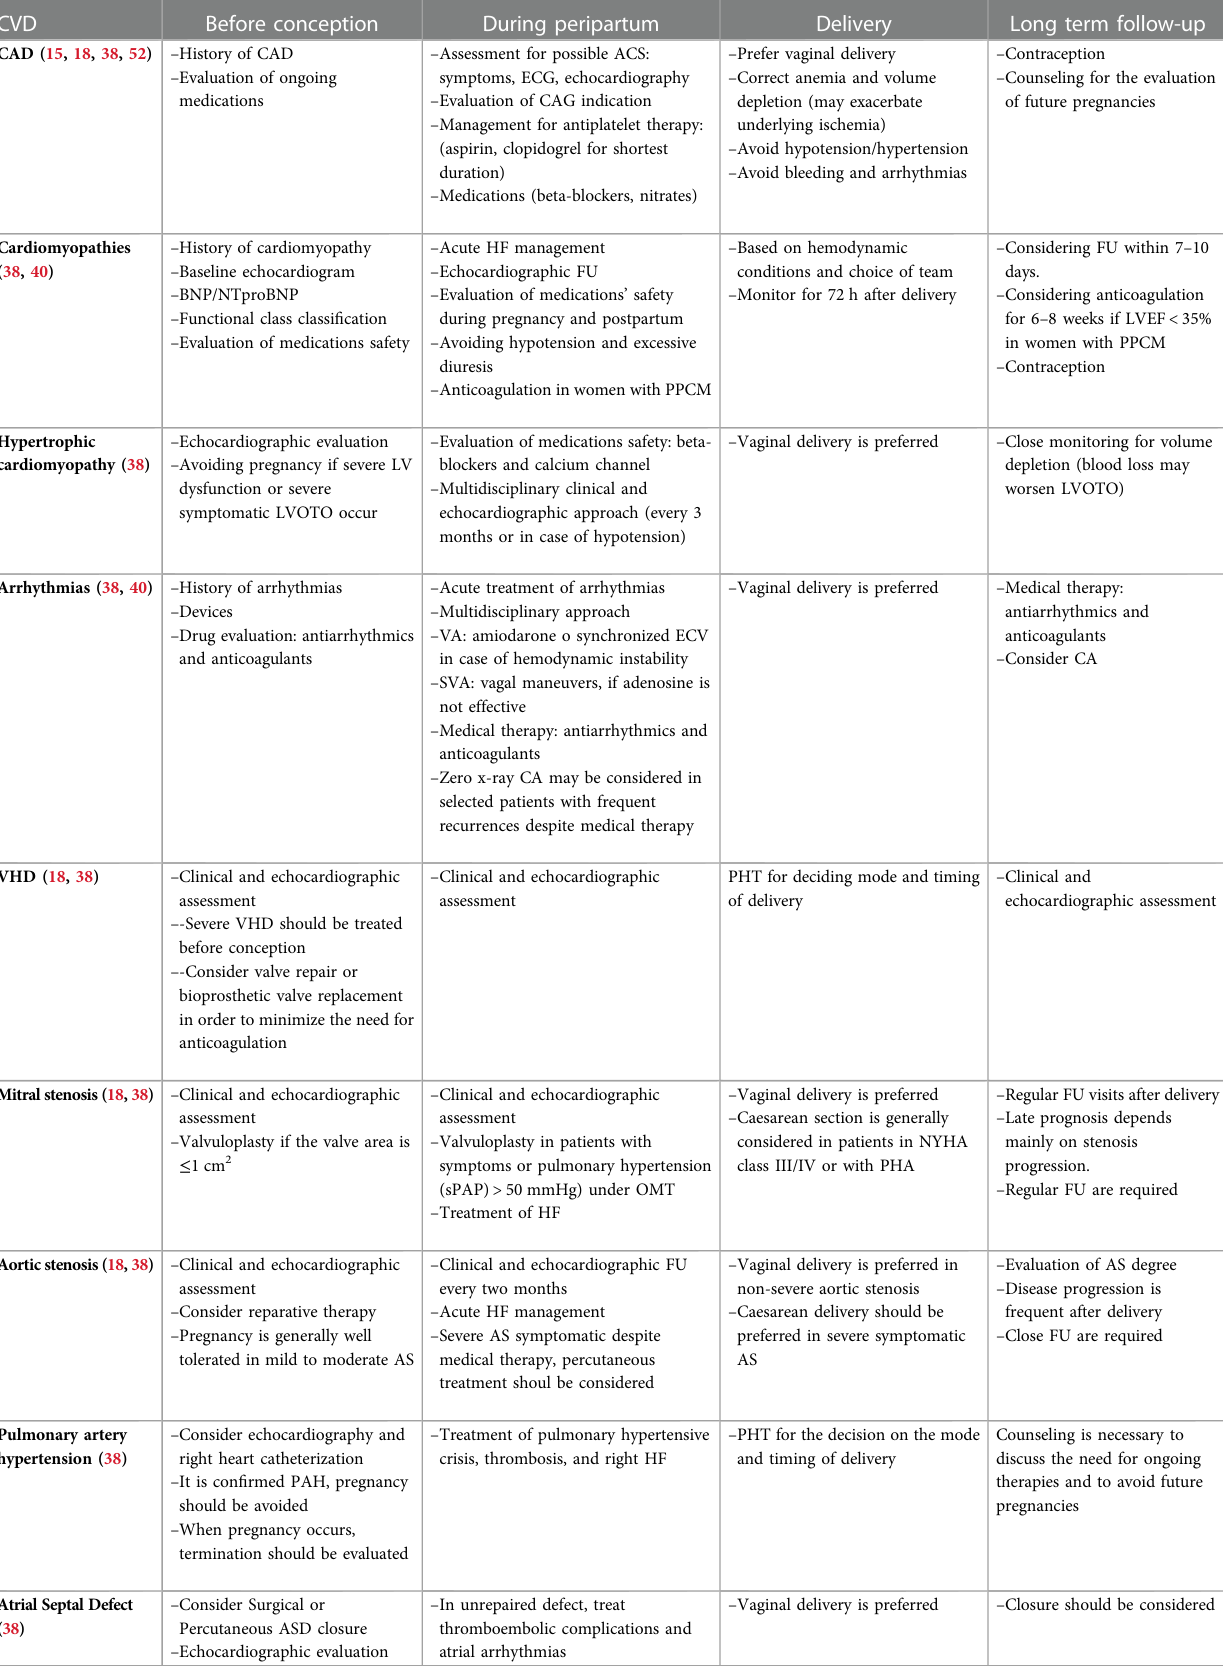
TABLE 1 Role of PHT evaluation before, during, and after pregnancy in the most common